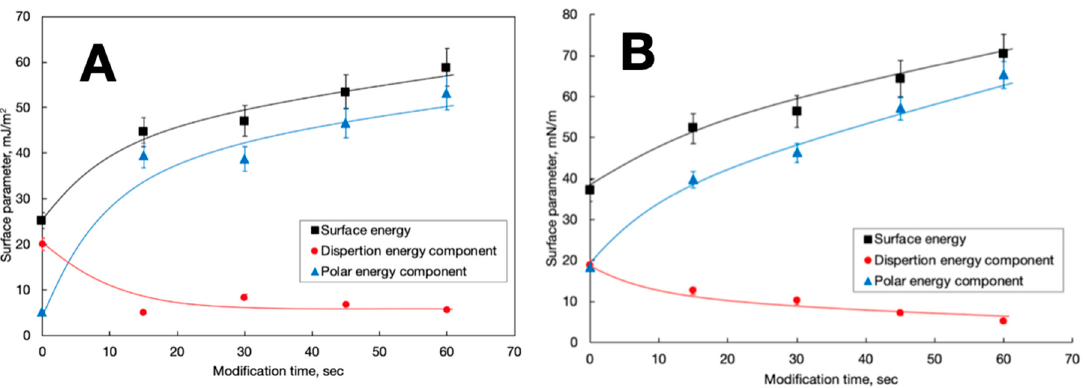
Figure 5. The dependences of the LDPE ( А ) and PET ( B ) substrates’ free surface energy and its components on the duration of electro-induced multi-gas modification.